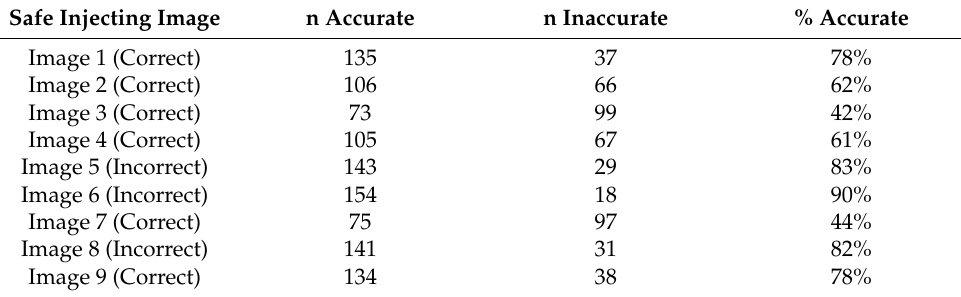
Table 5. Respondent accuracy in identifying correct and incorrect examples of immunisation.